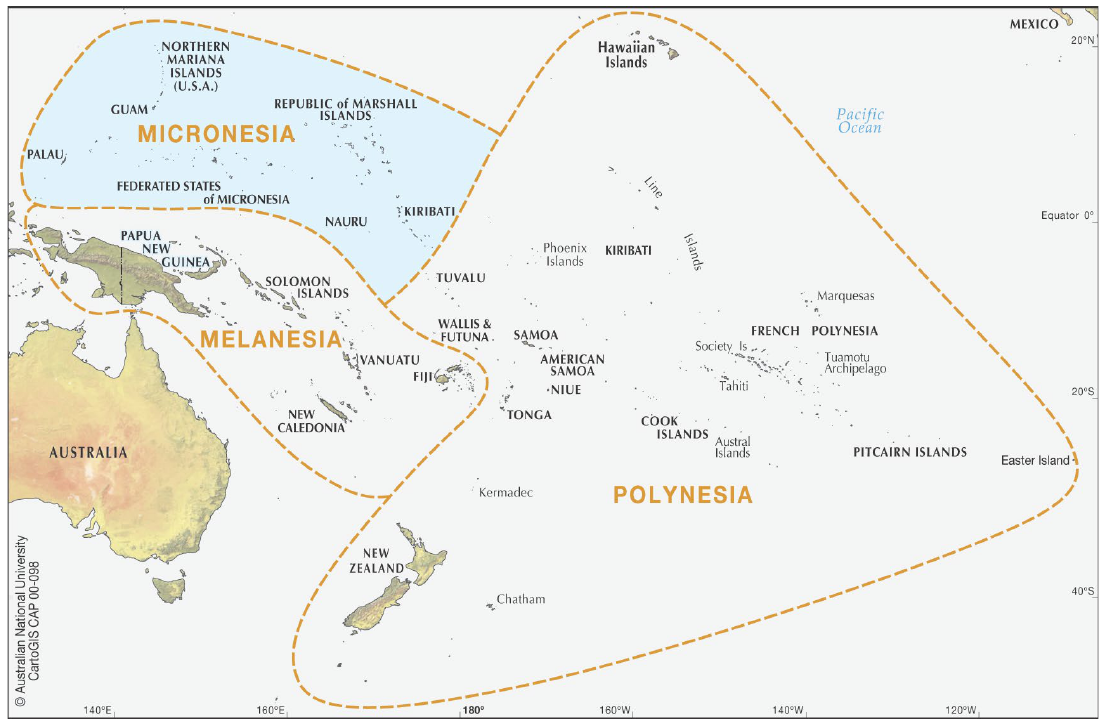
Figure 1. The three ethnogeographic regions from which Pacific Islanders trace their ancestry throughout the continent of Oceania: Micronesia, Melanesia, and Polynesia. The shaded area in blue represents the region and collection of island nations within Micronesia. The collection of approximately 2000 islands throughout the Federated States of Micronesia, Guam, Kiribati, the Republic of Marshall Islands, Nauru, Northern Mariana Islands, and Palau. Map provided by CartoGIS Services, Scholastic Information Services, The Australian National